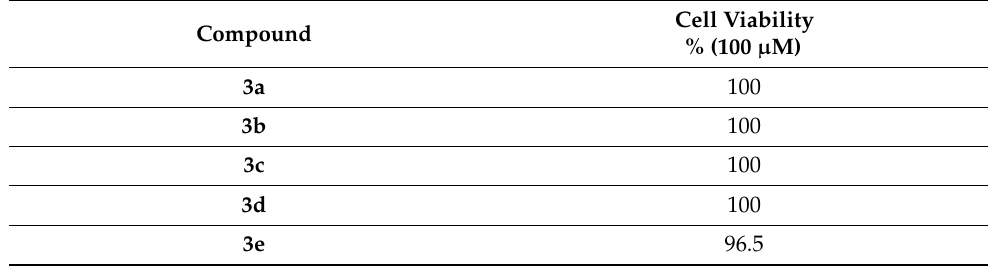
Table 4. Effects of the compounds on HaCaT cell line viability (%), at 100 µ